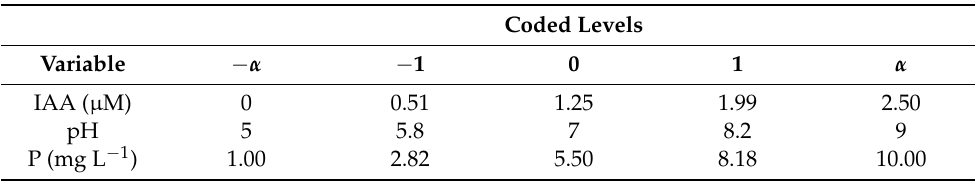
Table 3. Values of auxin (IAA), pH and phosphorus concentration for the central composite design ( α = 1.682).